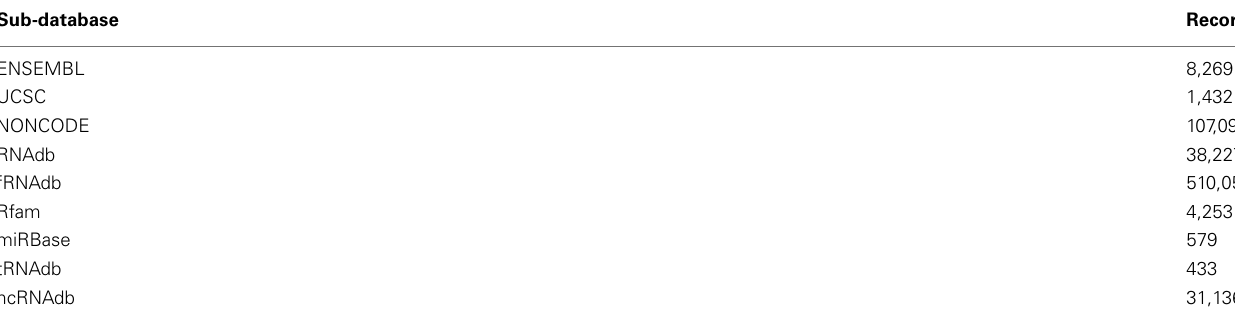
TableA4 |The summary of ncRNA database records. Sub-database